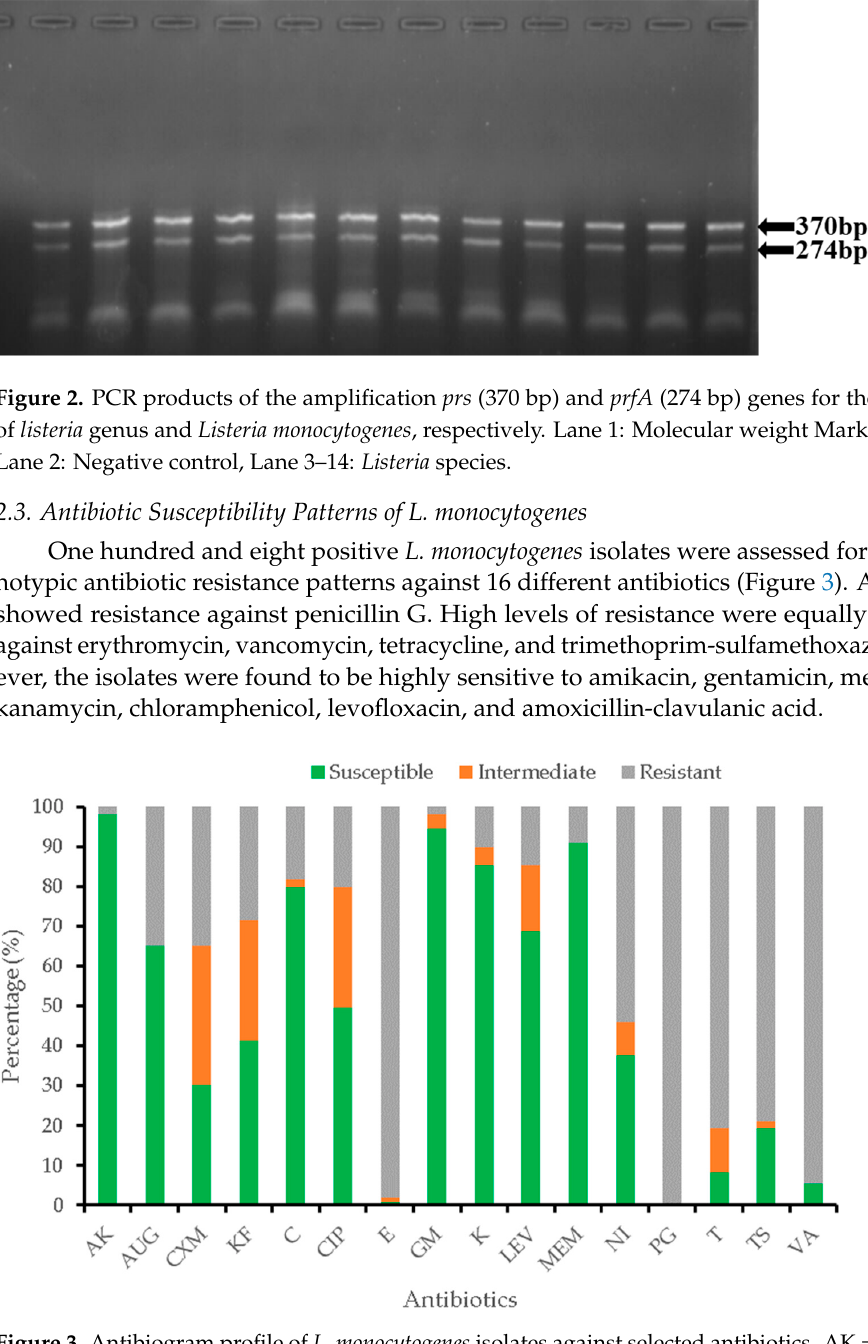
Figure 1. Distribution of presumptive Listeria species in vegetable samples.